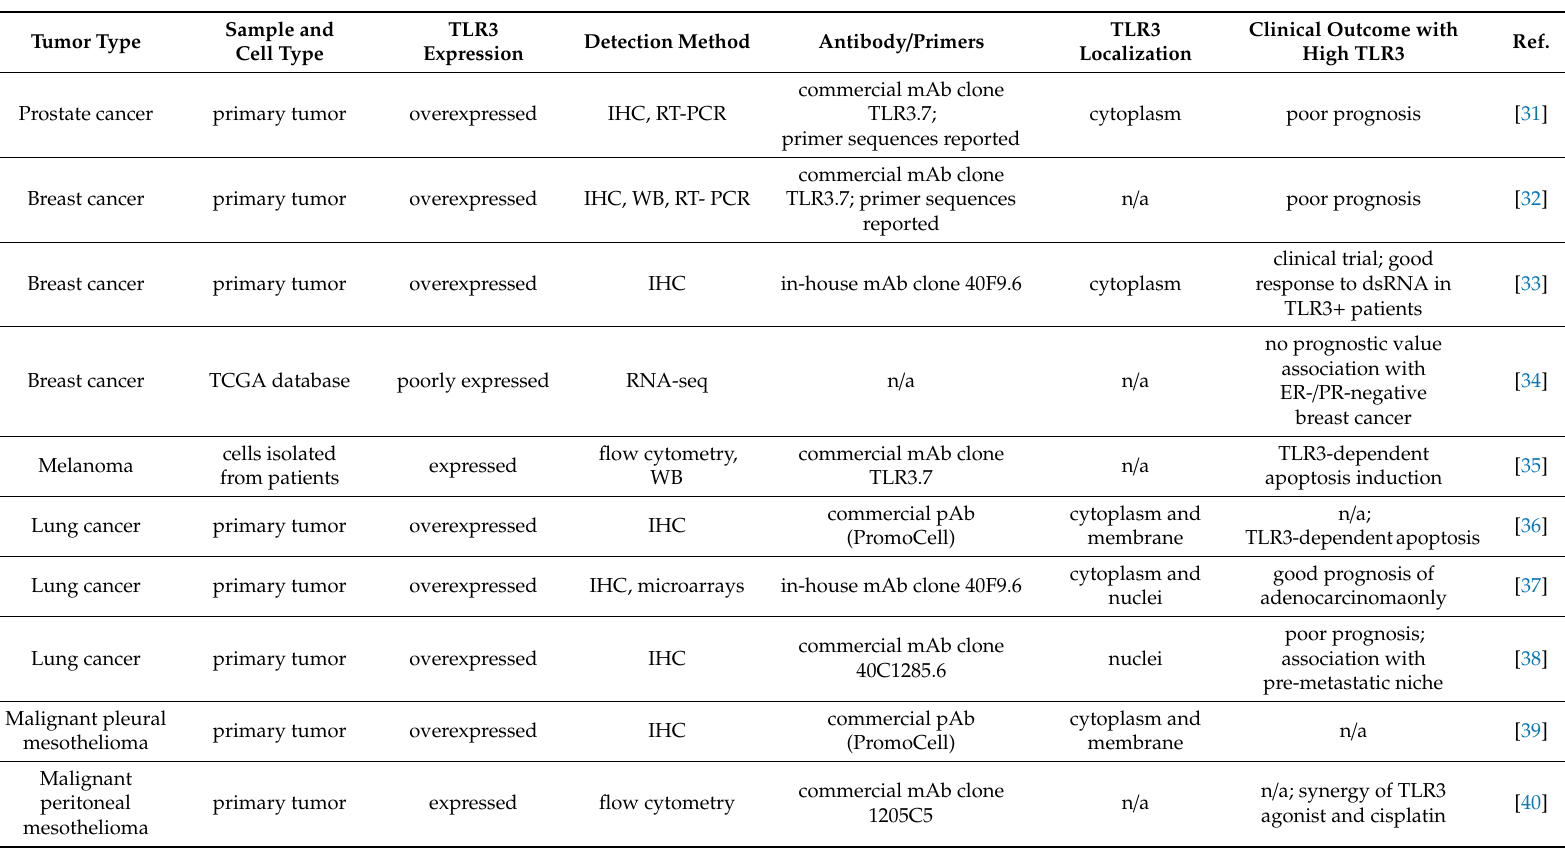
Table 1. Summary of TLR3 expression and association with clinical outcome in human cancer types. OSC, oral squamous cell; ESC, esophageal squamous cell; Ab, antibody; mAb, monoclonal antibody; pAb, polyclonal antibody; n / a, not available; IHC, immunohistochemistry; WB, western blot; RT-PCR, reverse transcription PCR; RNA-seq, RNA